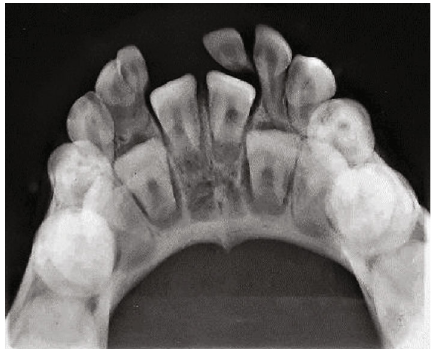
Figure 7: Anterior occlusal radiograph of the mandibular arch showing a type-4 morphology and an incomplete fusion of tooth 72 with a supernumerary